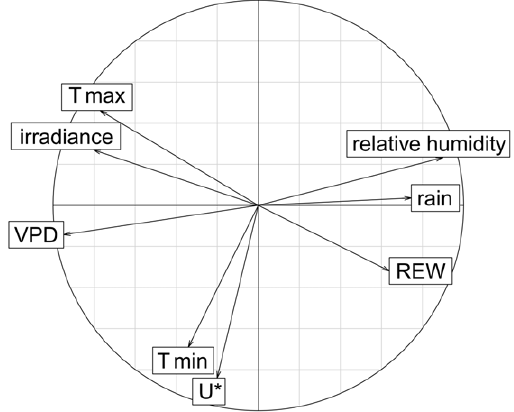
Figure 2. Principal component analysis of the climate variables. Note that the axis 1 and 2 explain respectively 50.8% and 20.6% of the total variation. The third axis explained a further 8.85% of the variance and was linked only to minimal temperature and REW